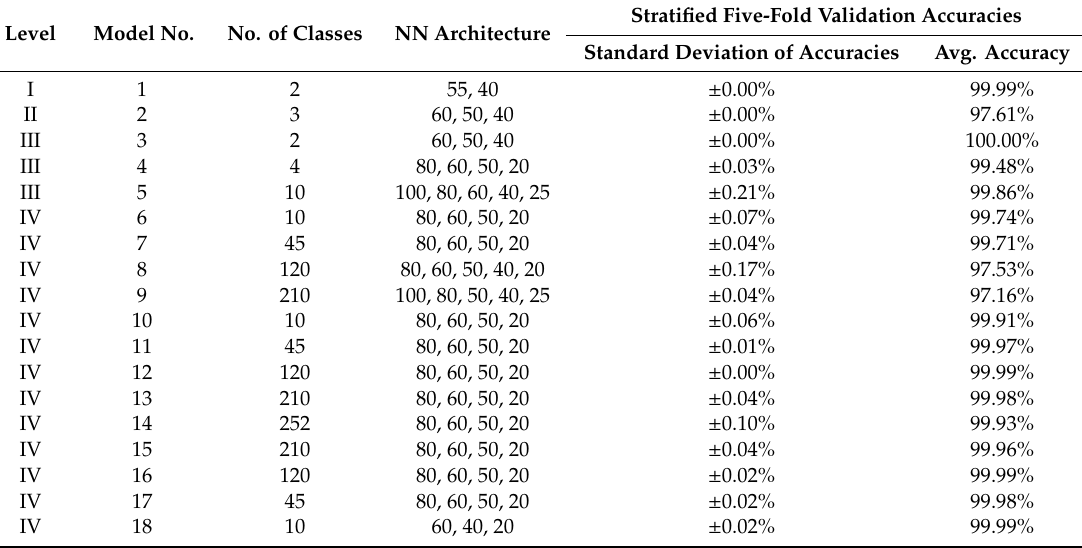
Table 3. Pre-trained neural network (NN) model architecture and pre-training results.